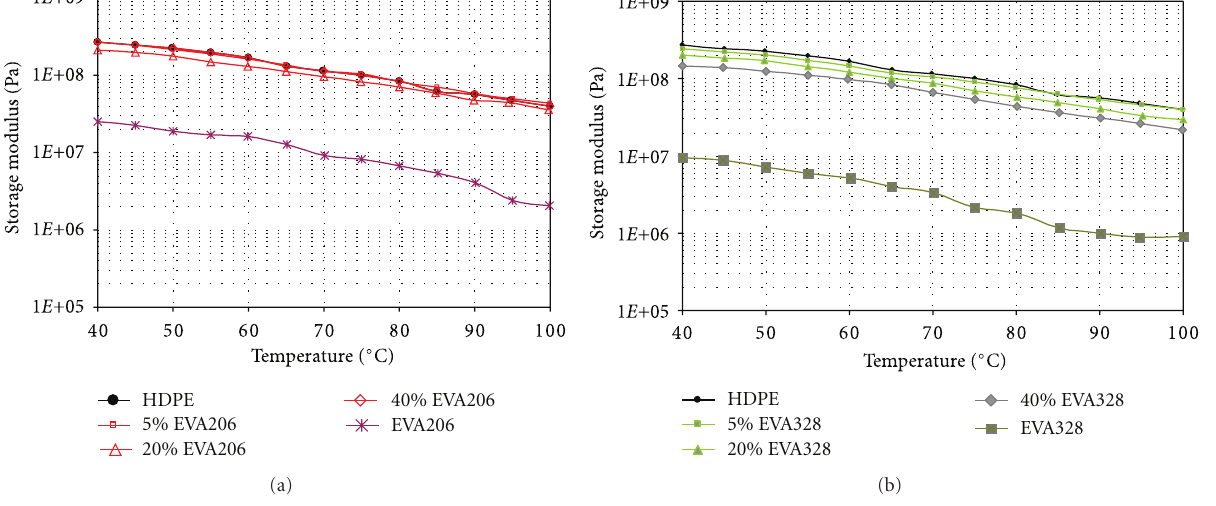
Figure 9: (a) E ff ect of temperature on the storage modulus of HDPE, EVA206, and their blends. (b) E ff ect of temperature on the storage modulus of HDPE, EVA328, and their